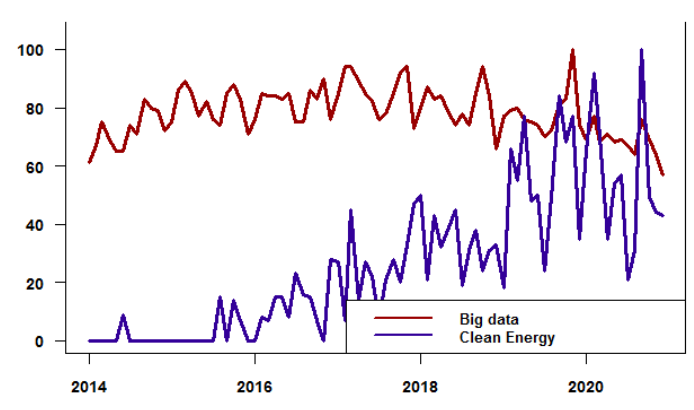
Figure 8. Big Data and SDG 7 global Google trends since